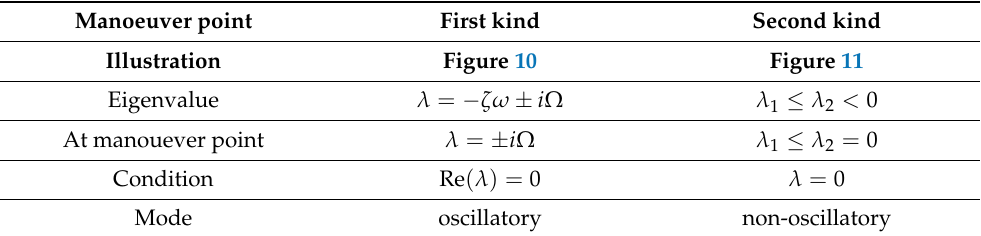
Table 13. Two kinds of manouever